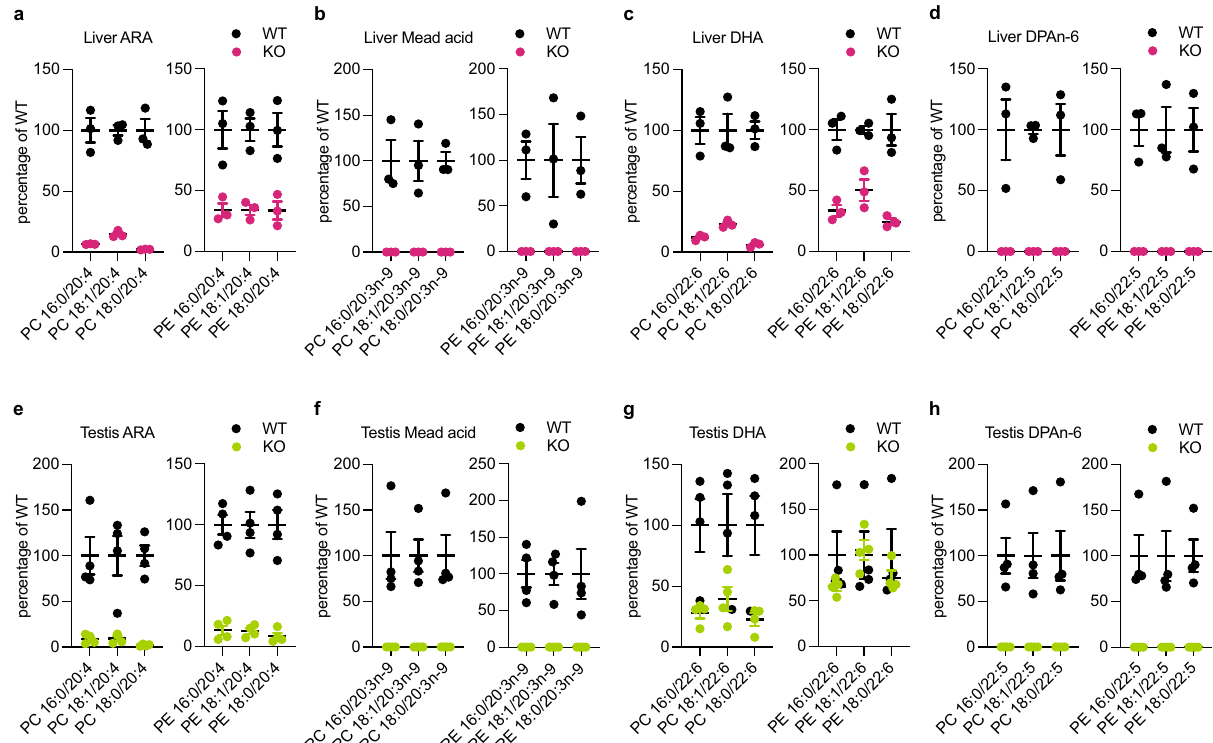
Fig. 2 HUFAs are reduced in FADS2 − / − liver and testis. Quanti fi cation of HUFA species of phosphatidylcholine (PC) and phosphatidylethanolamine (PE) in livers ( a – d ) and testes ( e – h ) from FADS2 + / + (WT) and FADS2 − / − (KO) mice. The values of each molecular species are expressed as a percentage relative to WT. n = 3 ( a – d ) and n = 4 ( e – h ) for each group. Data shown are the mean ± SEM. The detailed lipidomics data are shown in Supplementary Fig. 3. ARA arachidonic acid, DHA docosahexaenoic acid, DPA n-6 docosapentaenoic